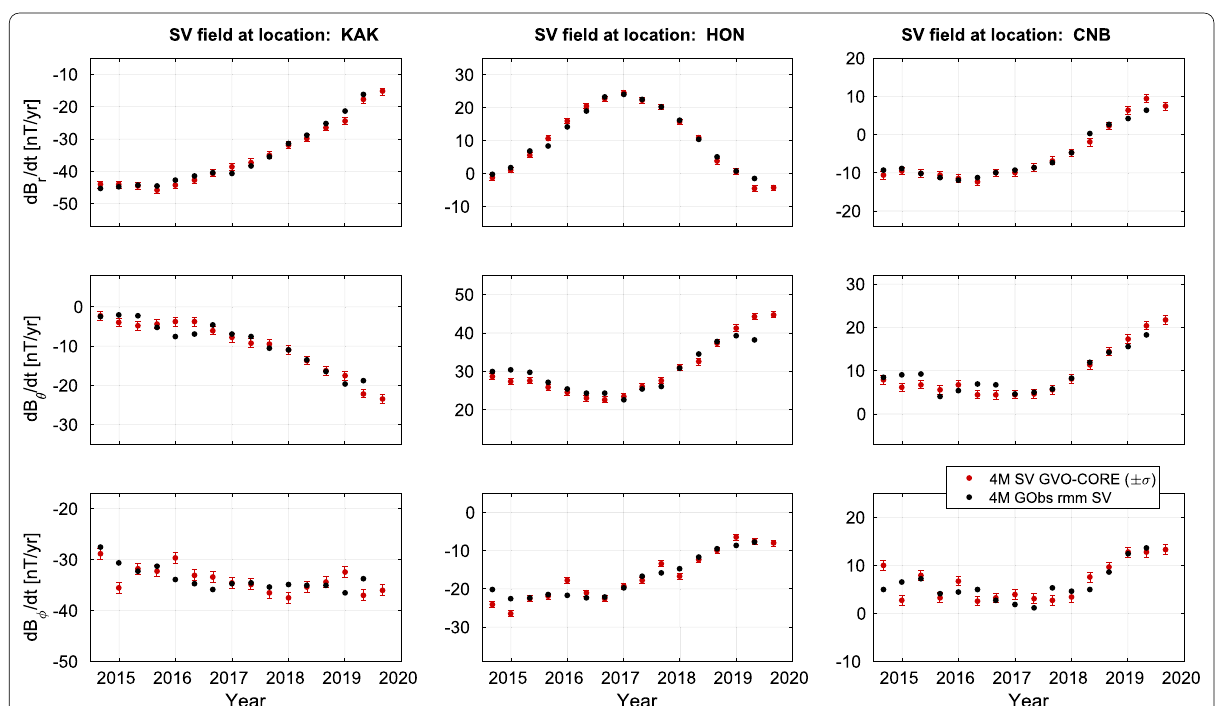
σ uncertainties, and 4-monthly revised means from ±